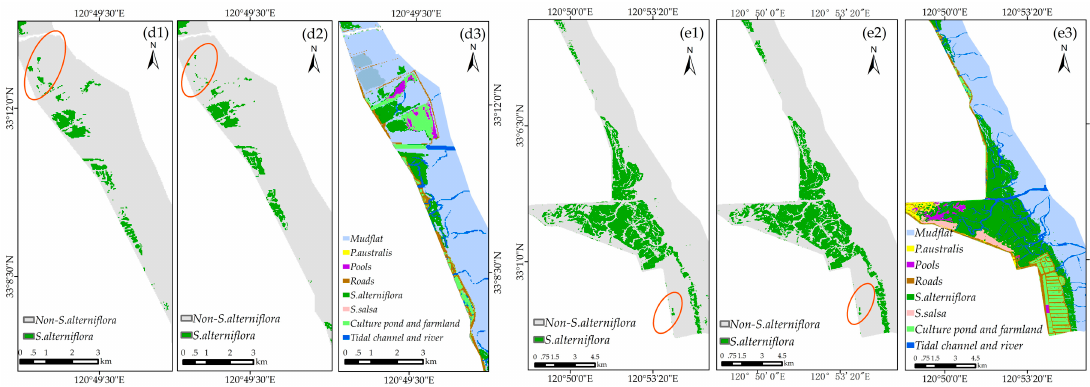
Figure 12. Classification map for S. alterniflora on the middle coast of Jiangsu constructed using the compressed time-series model with the training samples of 10 and 70. ( a1,b1,c1,d1,e1 ) are the identification results using 10 samples; ( a2,b2,c2,d2,e2 ) are the identification results using 70 training samples; ( a3,b3,c3,d3,e3 ) are the final land cover classification maps using the random forest classification method and visual interpretation; ( f ) overall view of the middle coast of Jiangsu; ( g ) overall view of the identification result using 70 training samples.